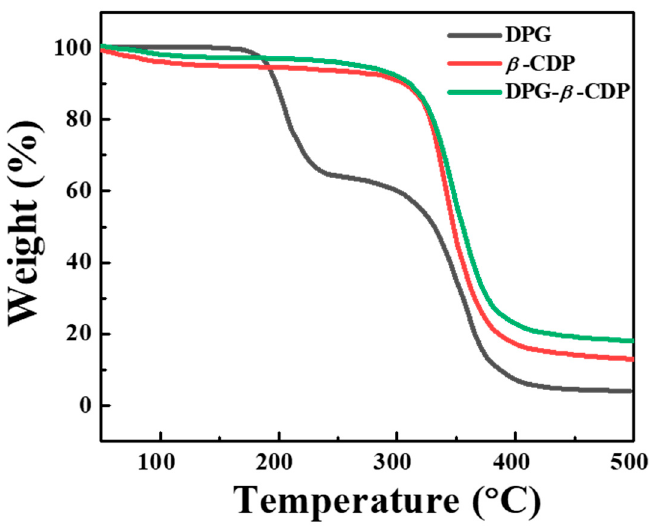
Figure 6. TGA curves of DPG- β -CDP, DPG, and β -CDP.